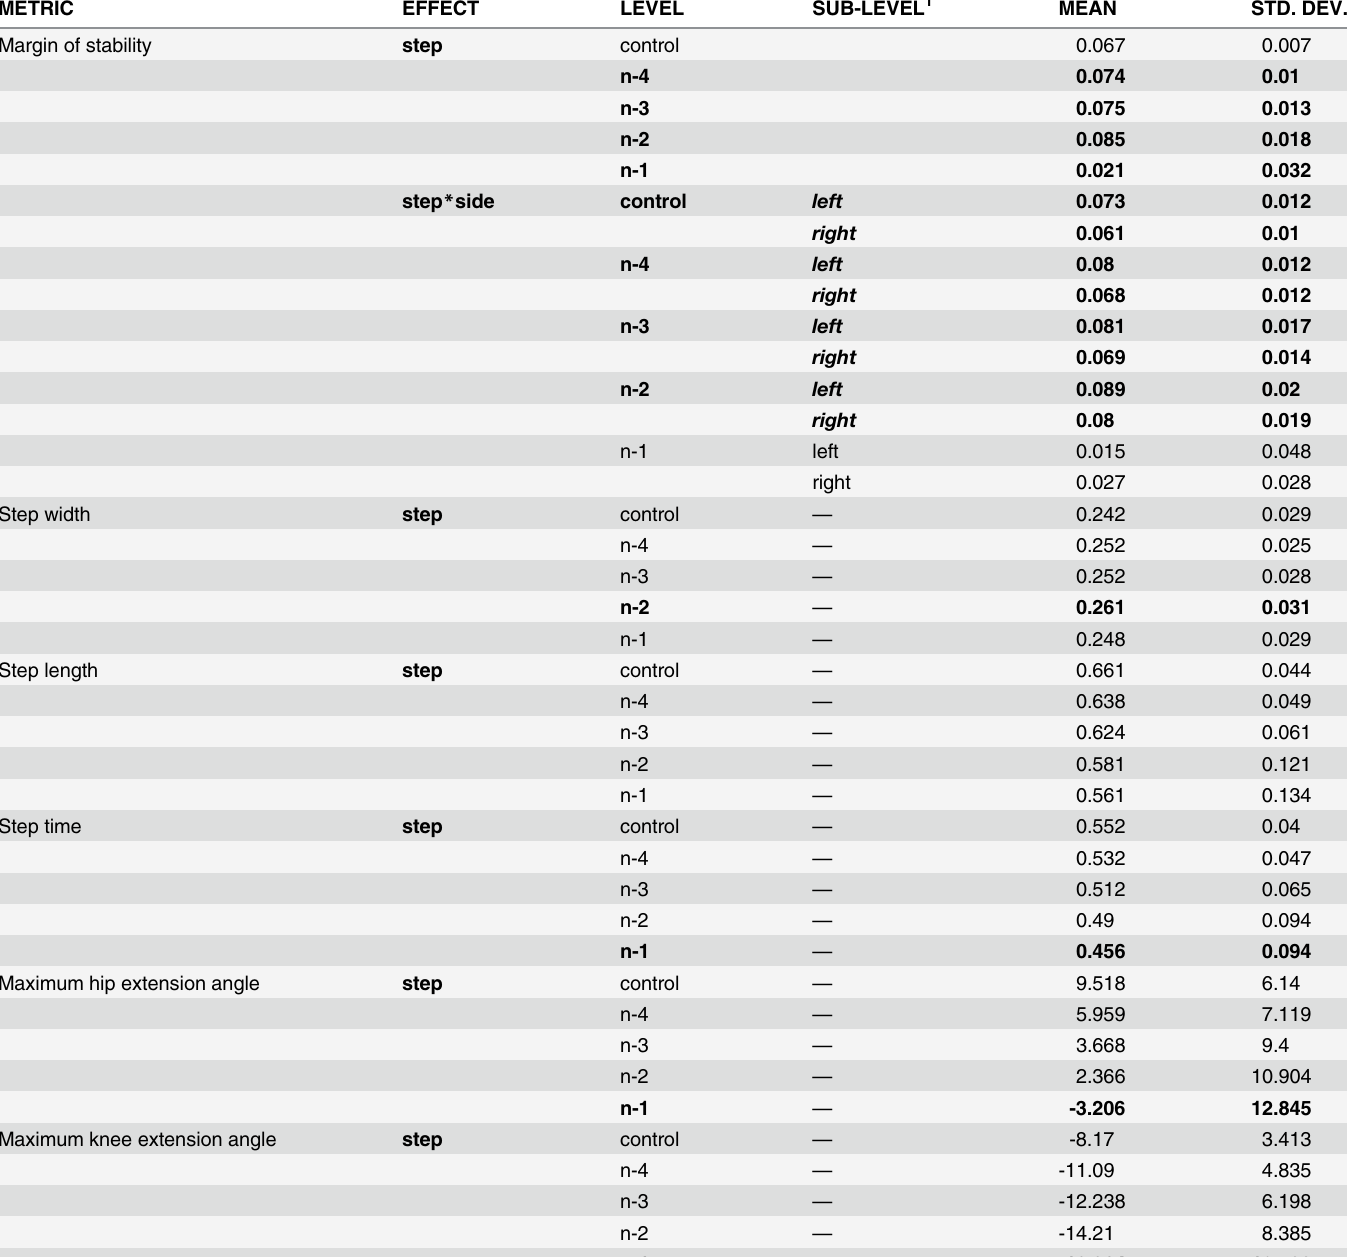
Table 1. Means and standard deviations for Known